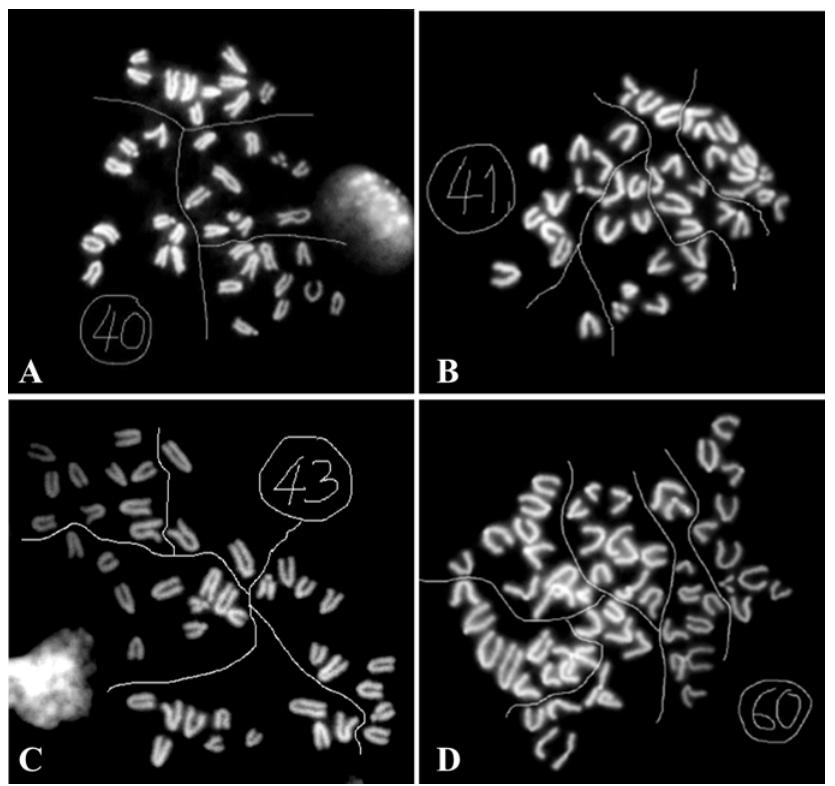
Fig 2. Typical images of metaphase chromosome spreads. A. A euploid cell with 40 chromosomes. B. A hyperploid cell with 41chromosomes. C. A hyperploid cell with 43 chromosomes. D. A triploid cell with 60 chromosomes. Lines are drawn to divide the spreads into 10-chromosome blocks, with the exception of the extra chromosomes in hyperploid karyotypes, to facilitate chromosome counting. doi:10.1371/journal.pone.0143360.g002 The minimum countable metaphase spreads for a positive karyotype were set at 12; a spe- cific karyotype (euploid, hyperploids or triploid, see Fig 2) was assigned based on the predomi- nant karyotype amongst the countable metaphase spreads (Table 1 and Table 2; Details can be found in S1 Table and S2 Table). A total of 54 retarded fetuses/resorptions were recovered from 10-month-old C57BL/6 mice (Table 1, “ CTRL ” ), yielding 37 positive karyotypes (all but one in the two groups: retarded and Grade 1 resorption).